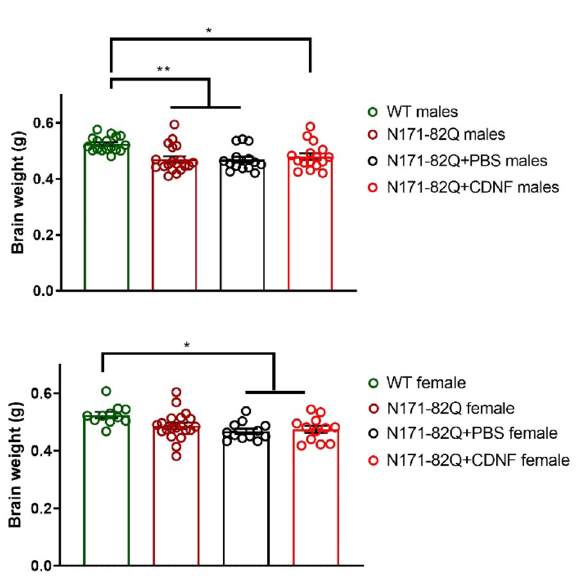
Figure 4. Clasping hindlimbs of N171-82Q mice. ( A ) Clasped hindlimbs (top photo) and unclasped hindlimbs (bottom photo). ( B ) Clasped hindlimbs in male mice. The CDNF-treated group presented statistically lower clasping scores than the vehicle group. * p < 0.05, ** p < 0.005, Kruskal–Wallis test, Dunn post hoc. The percentage of animals with totally clasped hindlimbs in the CDNF-treated group was significantly lower than in the control group. * p < 0.05, paired t-test. ( C ) The clasping score in female groups did not show a difference. The number of females with totally clasped hindlimbs was significantly lower compared to the control. p = 0.05, paired t-test. Values are the means ± SEMs. N per group = 14–26.